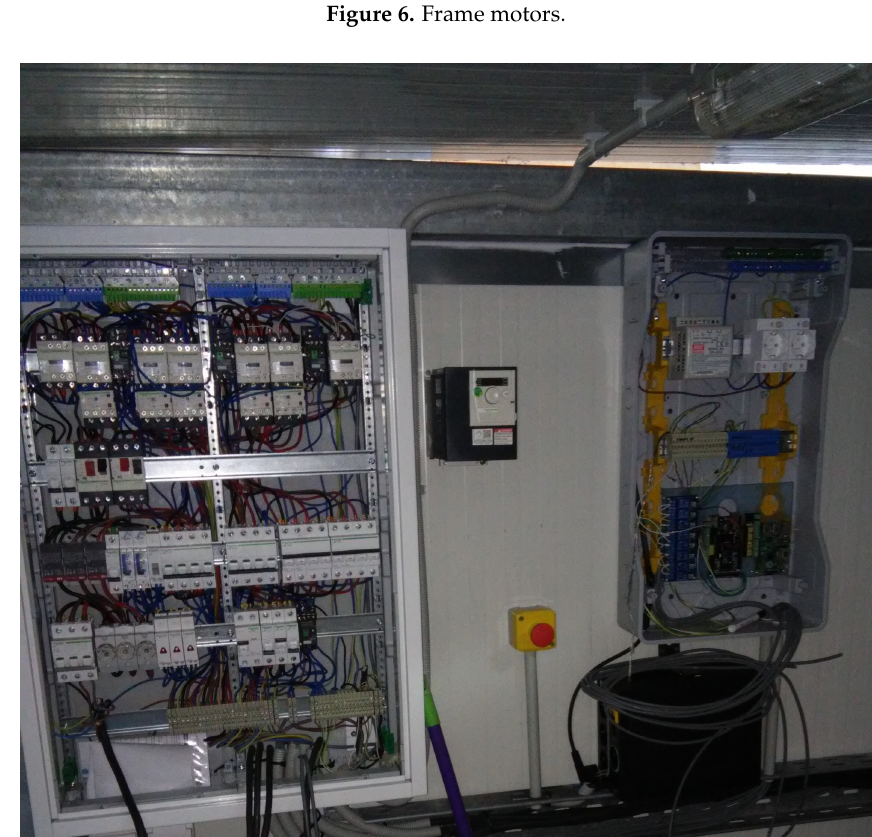
Figure 7. Electrical